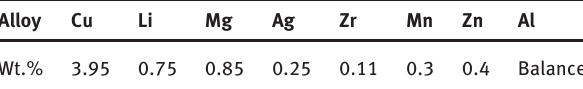
Table 1: Chemical composition of 2060 Al-Li alloy. Alloy